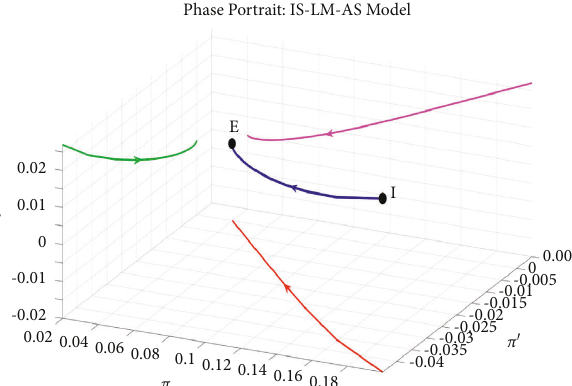
Figure 8: Projections at R 2 of the three-dimensional phase